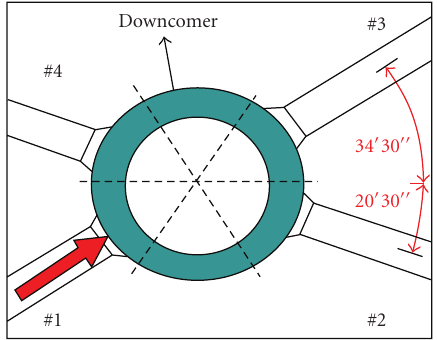
Figure 14: Location of the loops with respect to the